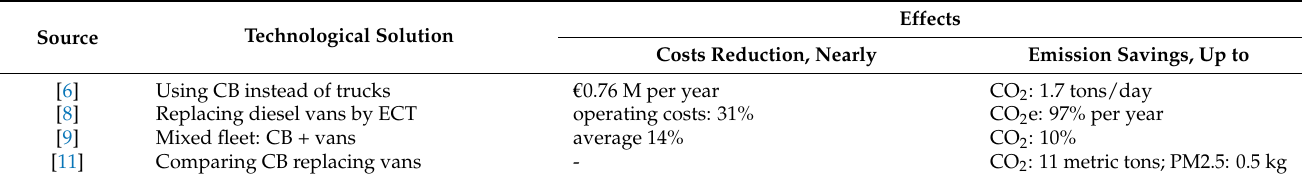
Table 4. Parameters achieved by estimation of the various delivery concepts aiming the reduction of the environmental and operational